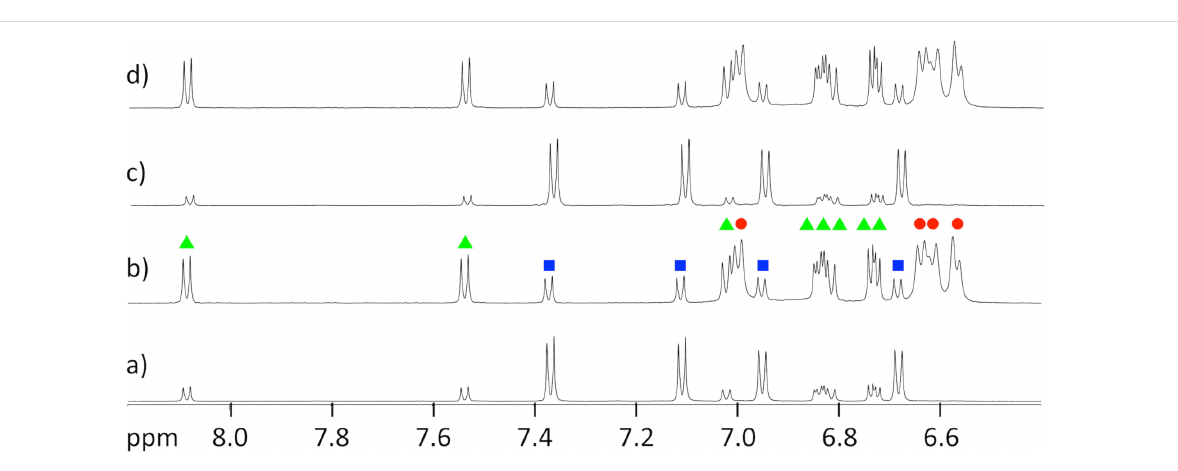
(Figure 5c). The switching process can be repeated without a significant change of the spectrum (Figure 5d; trans , trans / cis , trans / cis , cis ratio =